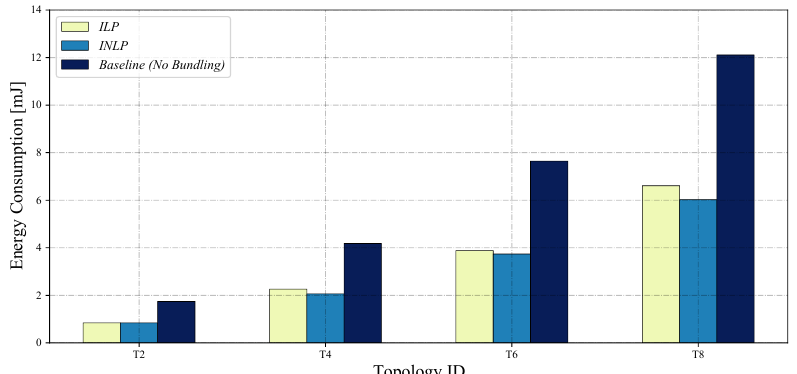
Figure 4. Total energy consumption based on the Cooja emulation.